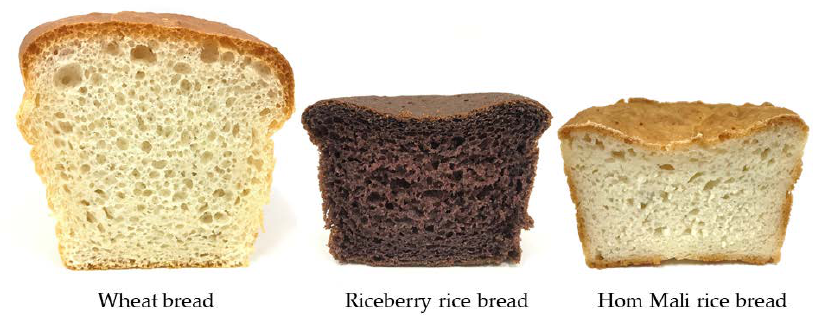
Figure 1. The cross-sections of wheat bread (WB), Riceberry rice bread (RRB), and Hom Mali rice bread (HMB), respectively.